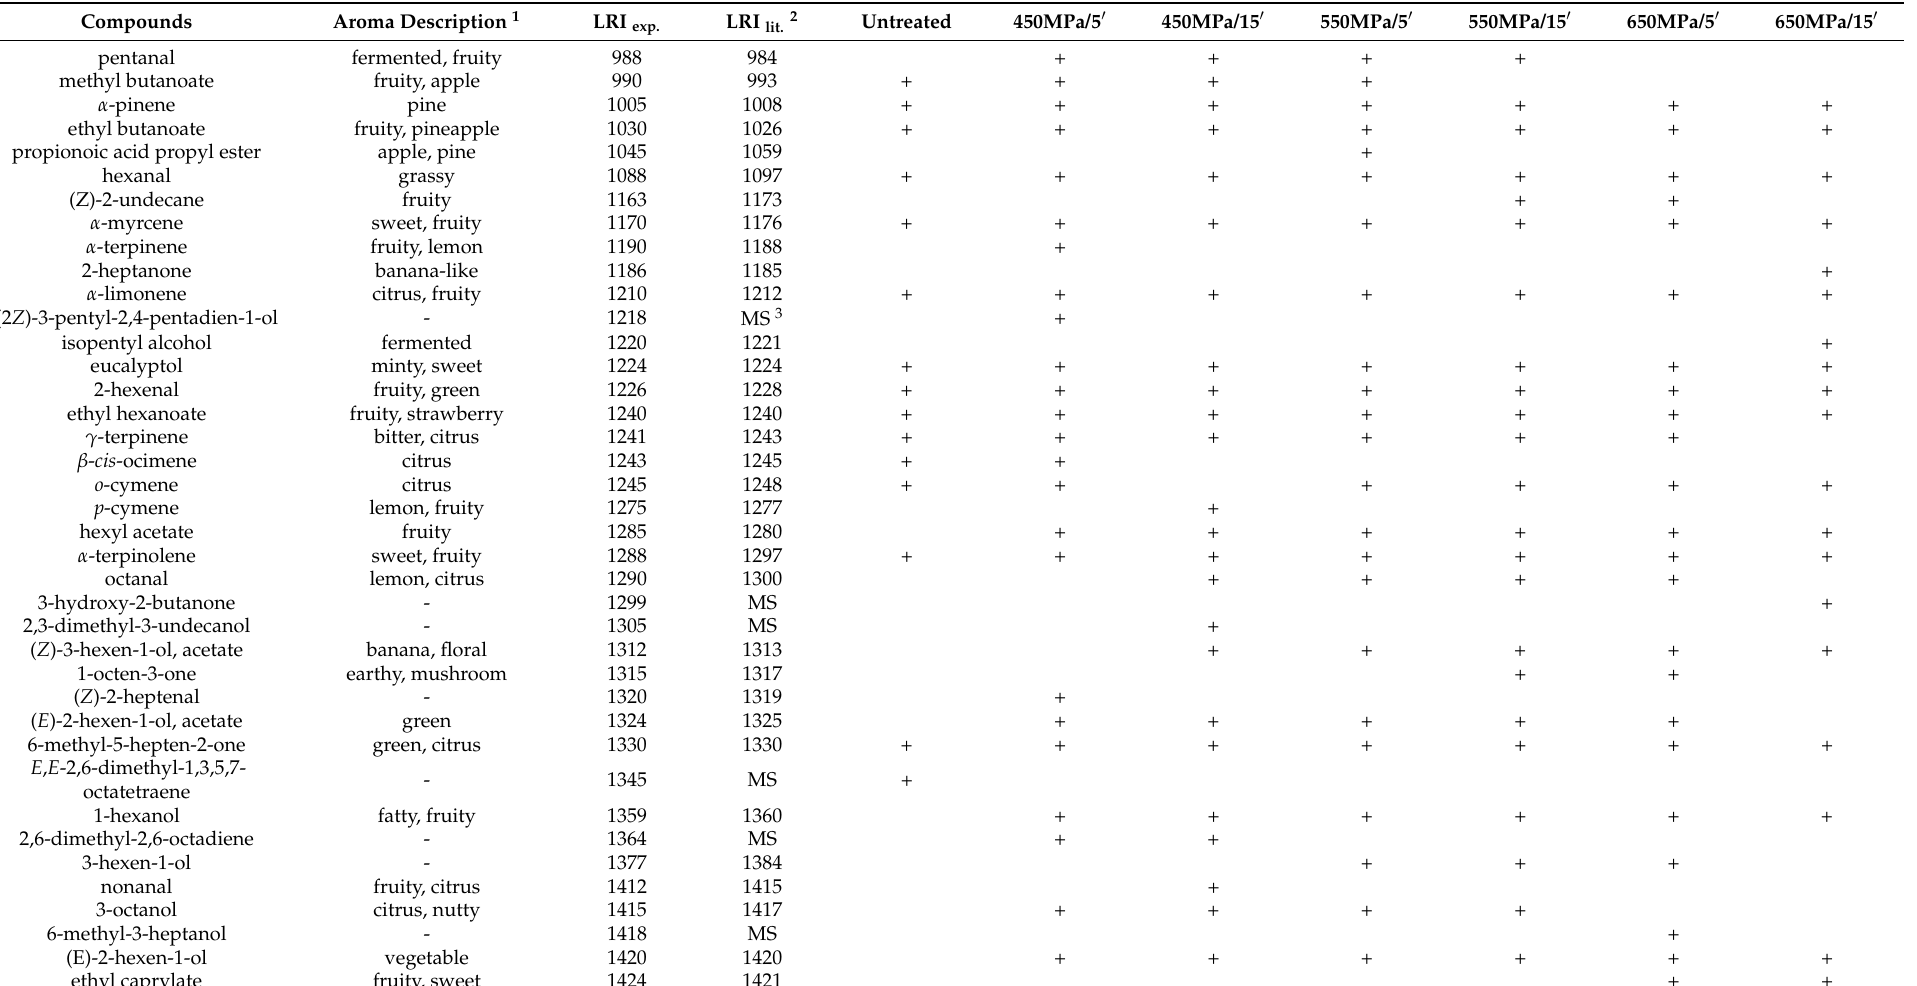
Table 2. Volatile organic compounds (VOCs) identified in the untreated and HHP-treated (450–550–650 MPa/5 and 15 min) cv Weiki. VOCs are listed according to the experimental linear retention indices (LRI exp.